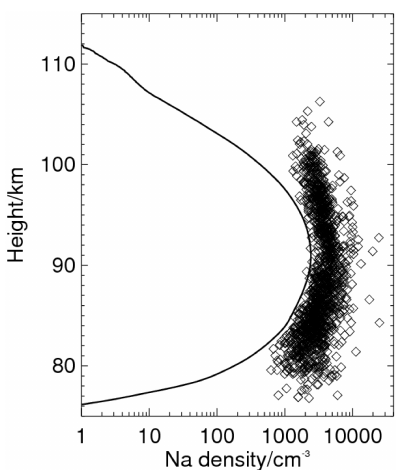
Figure 4. The distribution of the meteor trail peak density with the occurrence